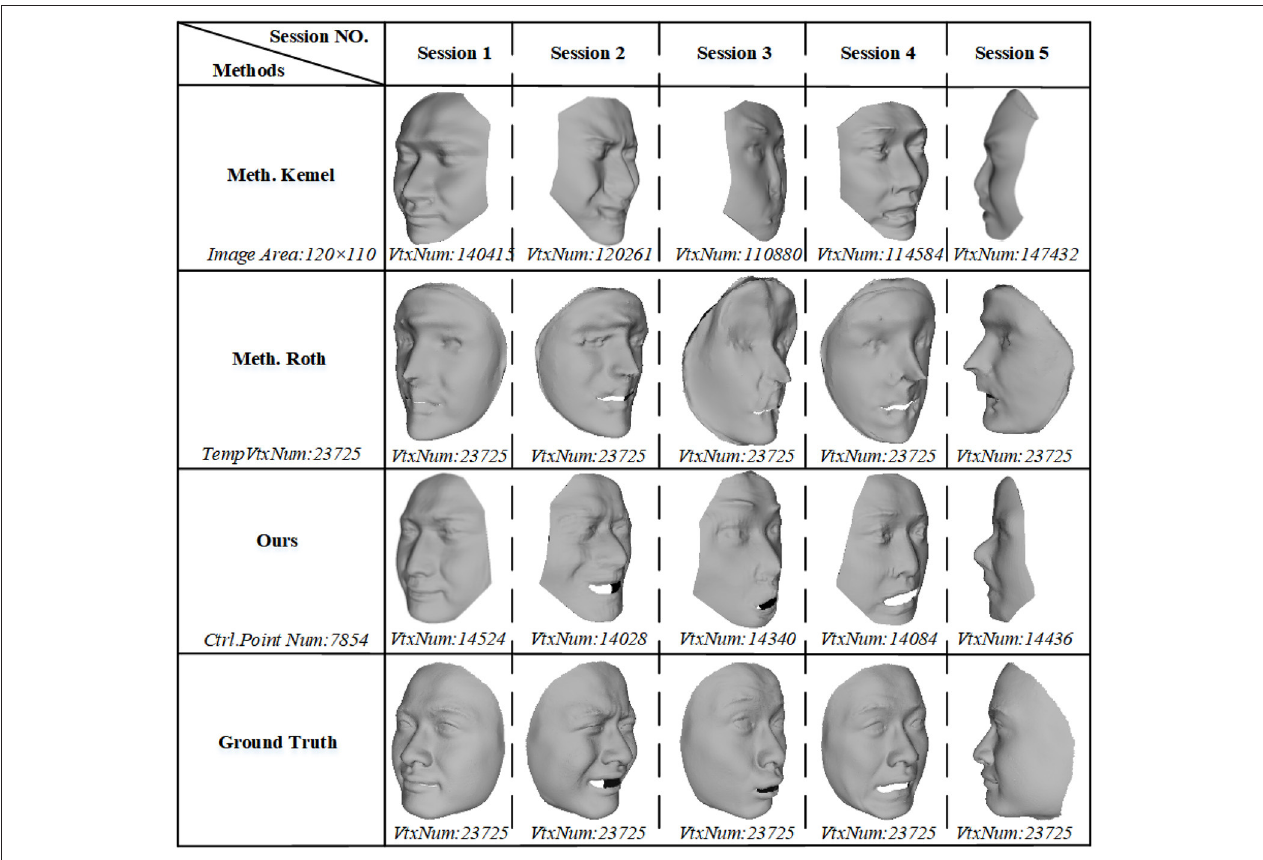
FIGURE 7 | Visual reconstructions and comparisons for session S1 , S2 , S3 , S4 , and S5 : for each session of reconstructions, a column lists the 3D results of Kemelmacher and Seitz (2011), Roth et al. (2015), and us, as well as ground truth. (VrxNum means vertex number; TempVtxNum means vertex number of template; and Ctrl.Point Num means the control point number of B-spline face surface. Particularly, the vertices of B-spline face are points sampled from the reconstructed parametric surface).